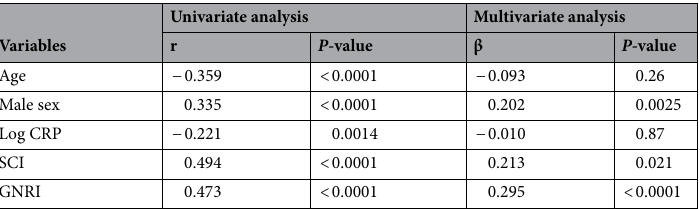
Table 2. Regression analyses of the associations between psoas muscle thickness per height and baseline variables. CRP C-reactive protein, SCI simplified creatinine index, GNRI geriatric nutritional risk index.